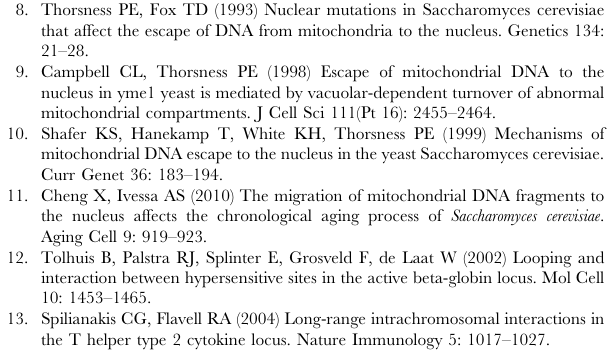
Table S4 Comparison between the Eco RI interaction set from Duan et al. [ 46 ] and the glucose set from this